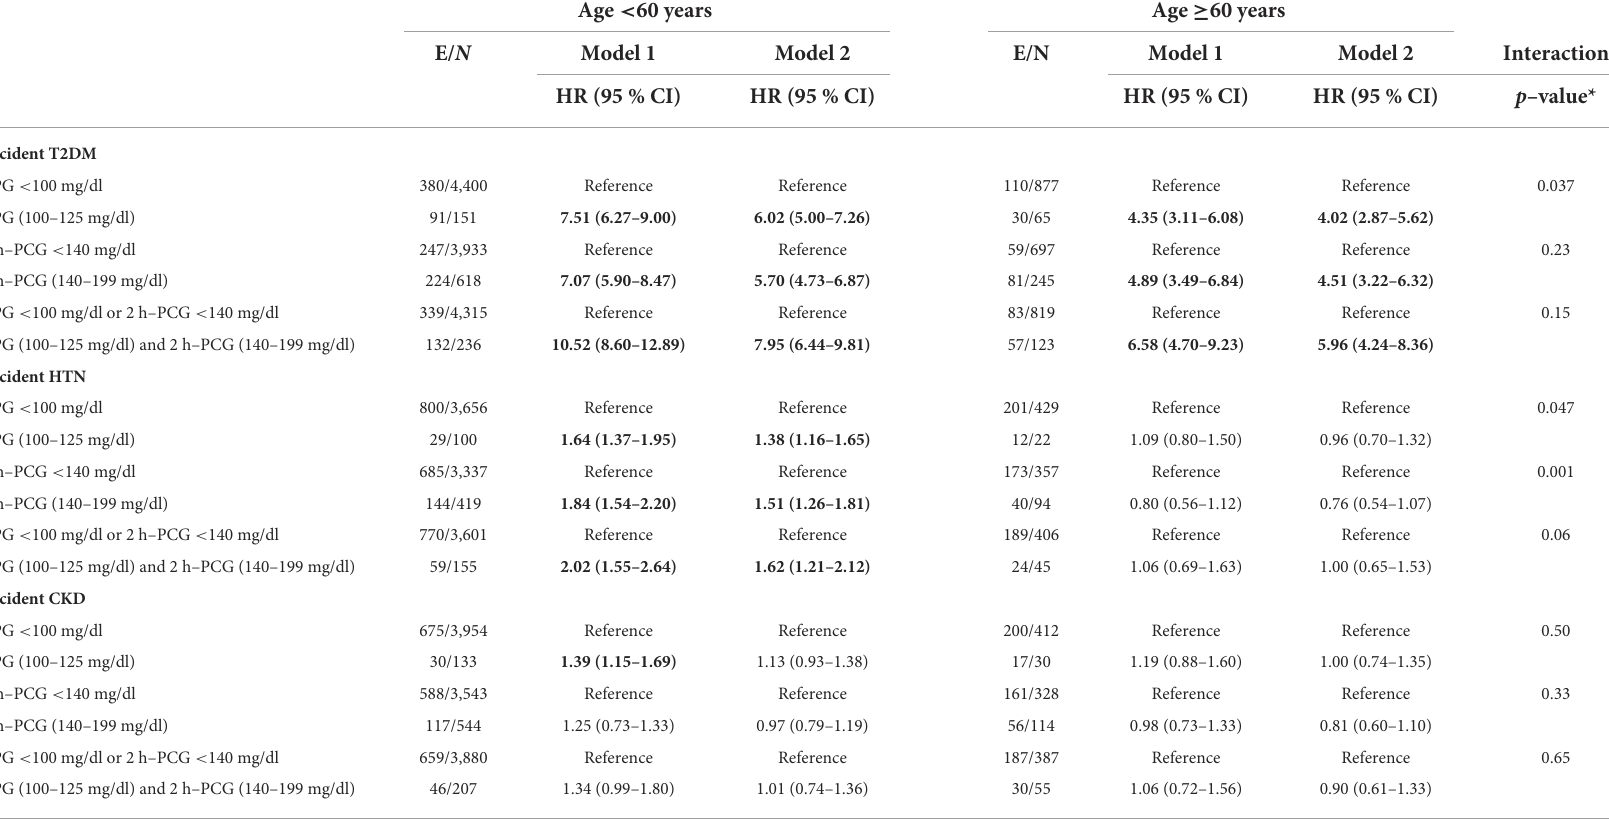
TABLE 2 Adjusted hazard ratios (95 % CI) for incident T2DM, HTN, and CKD by age groups: Tehran lipid and glucose